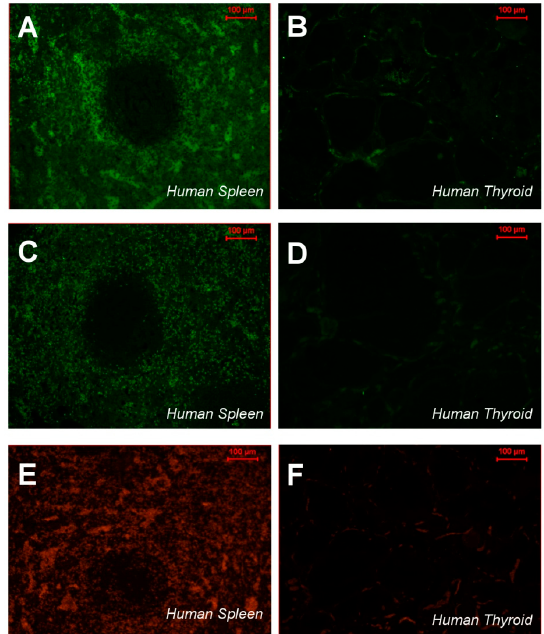
Figure 3. Immunofluorescence to CTHRSSVVC-phage, Fd-phage and CD163 expressions: ( A , B ) CTHRSSVVC-phage localization ( green ) to spleen and thyroid; ( C , D ) Fd-insertless phage localization ( green ) to spleen and thyroid; and ( E , F ) CD163 expression ( red ) to spleen and thyroid respectively, revealed by immunofluorescence and photographed with an AxioVision (Carl Zeiss Inc., Jena, Germany) microscope. Phages bound to tissue were revealed using an anti-bacteriophage antibody. The thyroid tissue (negative control), the reactions resulted negative. Bar, 100 µm in all panels.